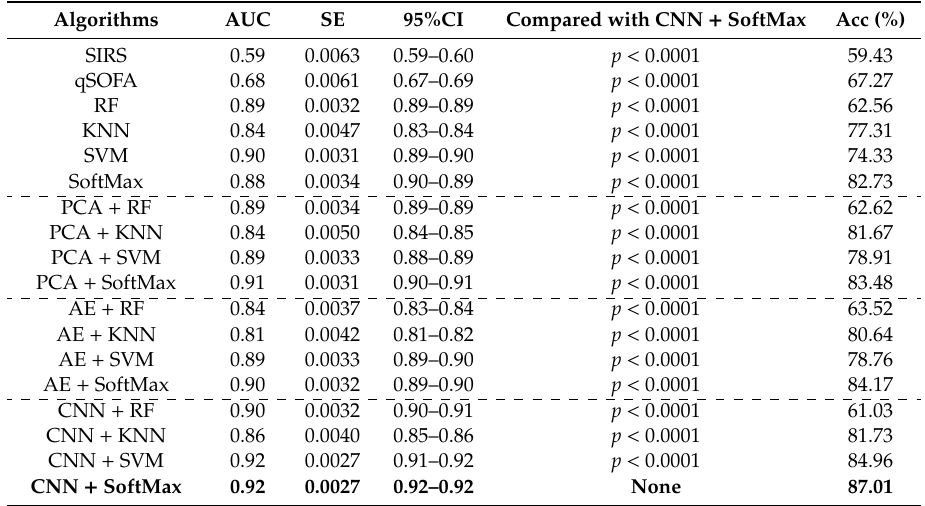
Table 2. AUC with 95% confidence interval and the accuracy rate of various methods in predicting 28-days mortality and compared with CNN plus SoftMax by Delong test.